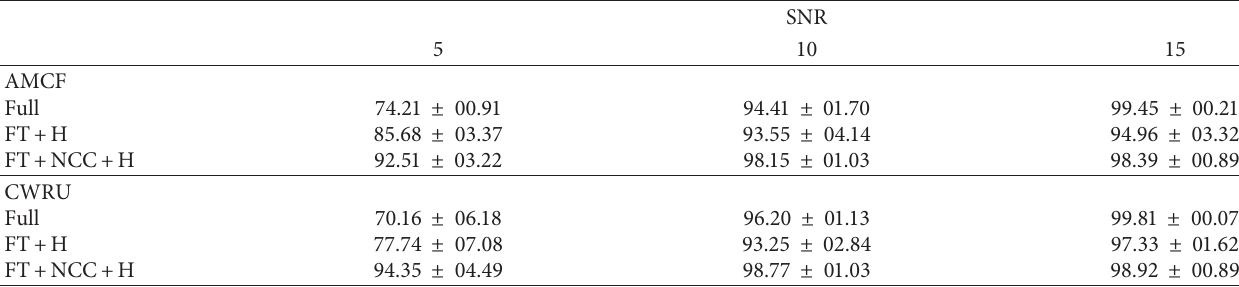
Figure 6: Impact of the herding method for exemplar selection on (a) AMCF and (b) CWRU. Herding method is marked as +H, whereas a random selection is marked as +R. Table 7: Accuracy performances and standard deviations for evaluated solutions under different noise levels on AMCF and